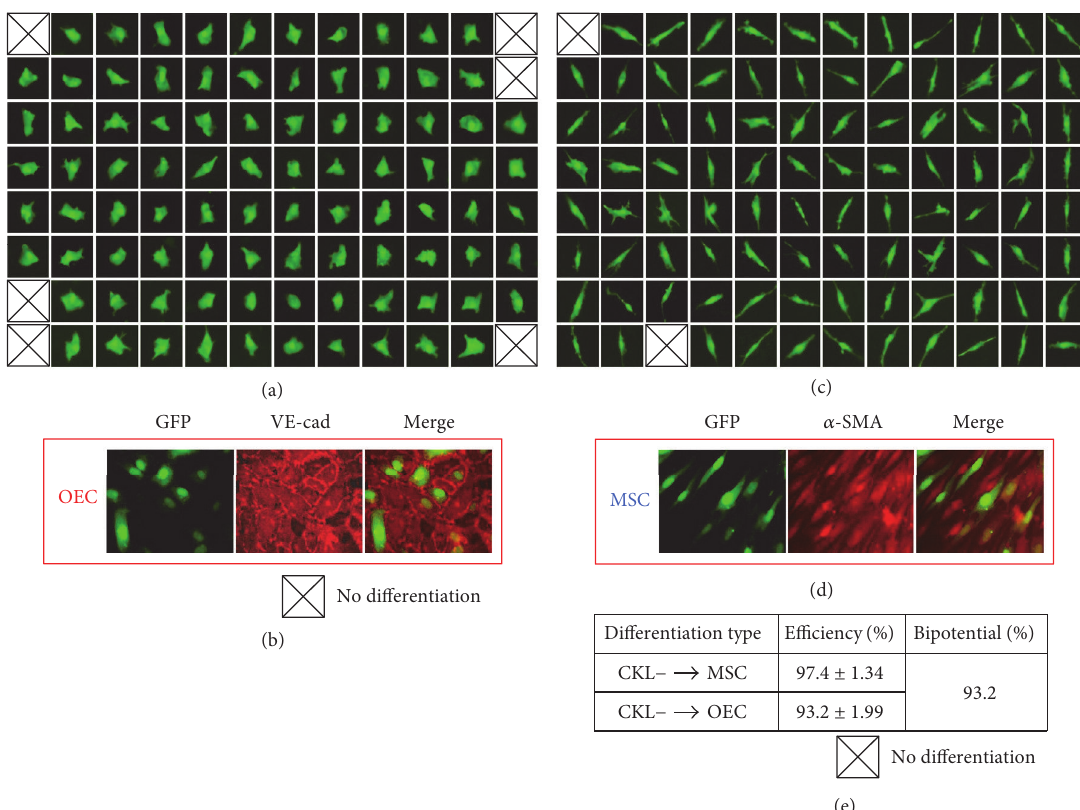
Figure 4: CKL − cells have multilineage differentiation potential depending on environmental factors. (a, c) Single GFP + CKL − cells were on OEC- or MSC-conditioned medium. (e) The differentiation efficiency of CKL − cells into OECs and MSCs on day 4 was 93.22% and 97.37%, respectively. (b, d) The phenotype of differentiated GFP + OECs or MSCs was confirmed by immunofluorescent staining for VE-cadherin or 𝛼 -SMA antibody,